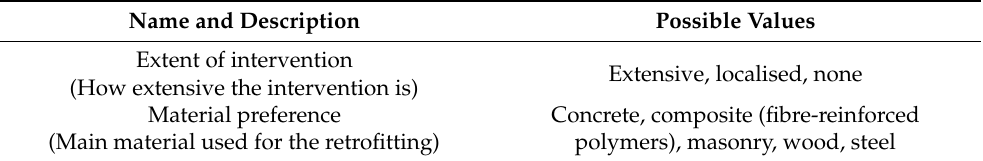
Table 6. Seismic retrofitting intervention.